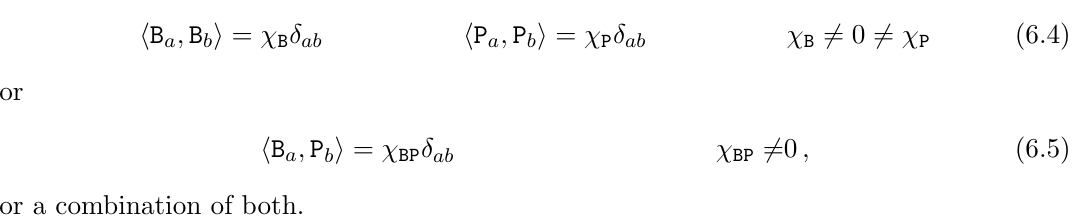
; X ab for J ab ; J (cid:3) . The metric is nondegenerate for (cid:31) 6 = 0. B a ab ; P g is a a